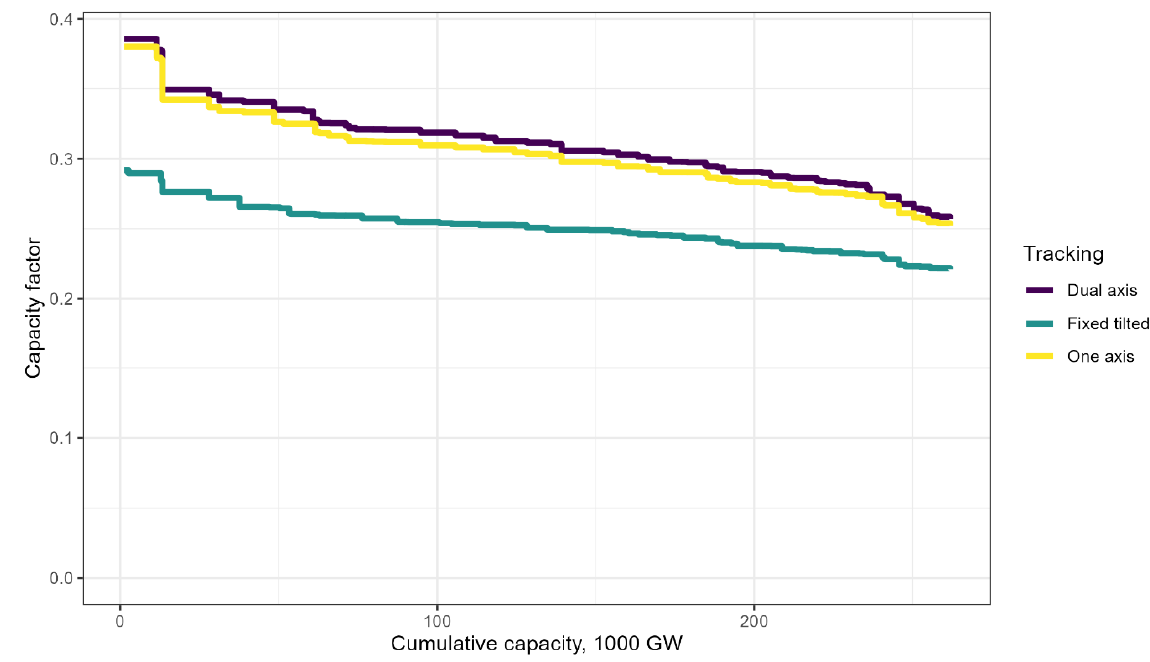
Figure A8. Solar PV capacity factors (1980–2020 average) with potential cumulative capacity by cluster, assuming 1% use of territory of each cluster.